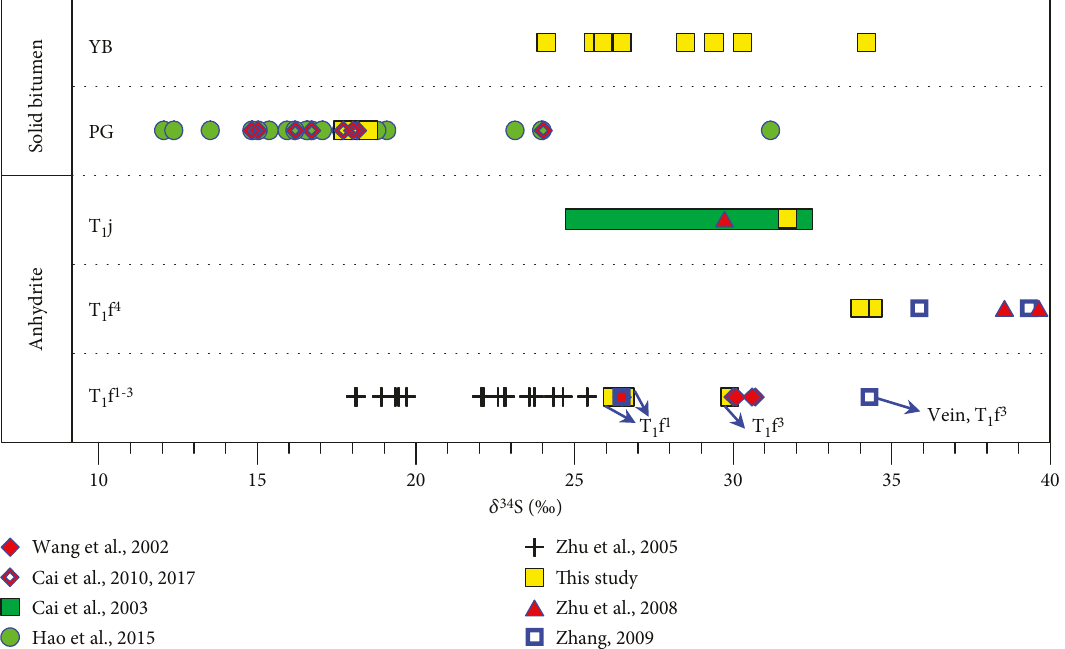
Figure 9: Correlation between the sulfur isotopes of the solid bitumen and anhydrite samples in the northeastern part of the Sichuan